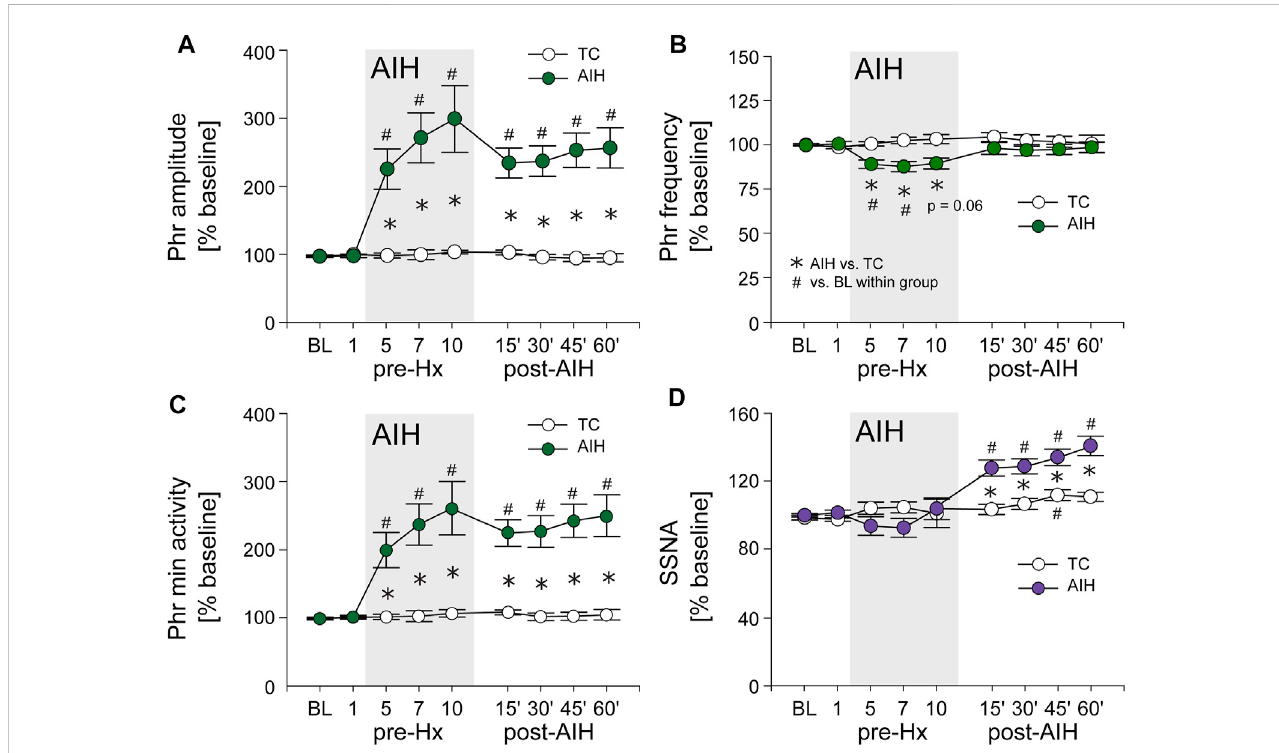
FIGURE 3 AIH induces long-term facilitation (LTF) of both PhrNA and SSNA. (A) , Phr amplitude; (B) , Phr frequency; (C) , Phr min activity; (D) , SSNA in periods of breathing O 2 enriched air before (BL, pre-Hx 1), within (pre-Hx 5, 7, 10; grey box) and after (15 ′ , 30 ′ , 45 ′ , 60 ′ ) AIH or TC protocols in animals exposed to AIH (green (PhrNA) or purple (SSNA) circles; n = 13) or TC (white circles, n= 6, PhrNA; n= 7, SSNA). Two-way repeated measures ANOVA: p ≤ 0.05; *AIH vs. TC, # relative to pre-AIH baseline within a